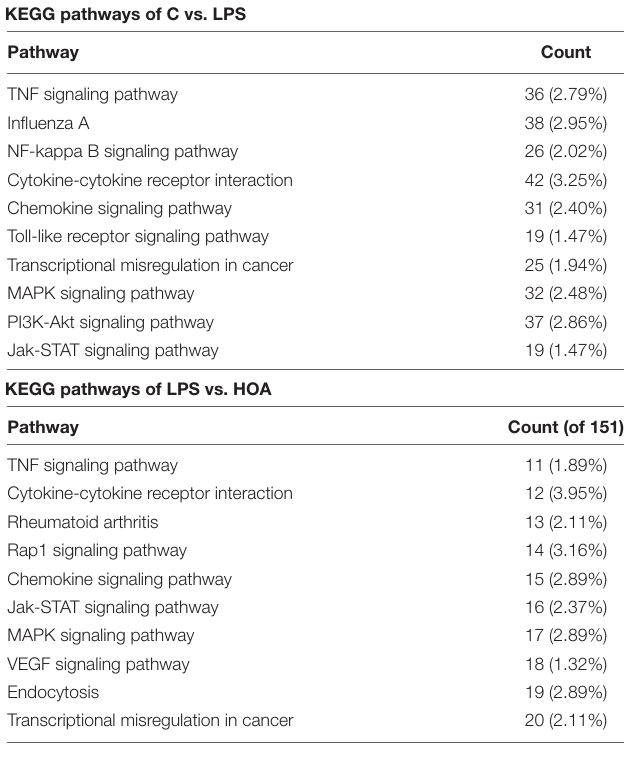
TABLE 3 | Top 10 of KEGG pathways of C vs. LPS and HOA vs. LPS. KEGG pathways of C vs. LPS